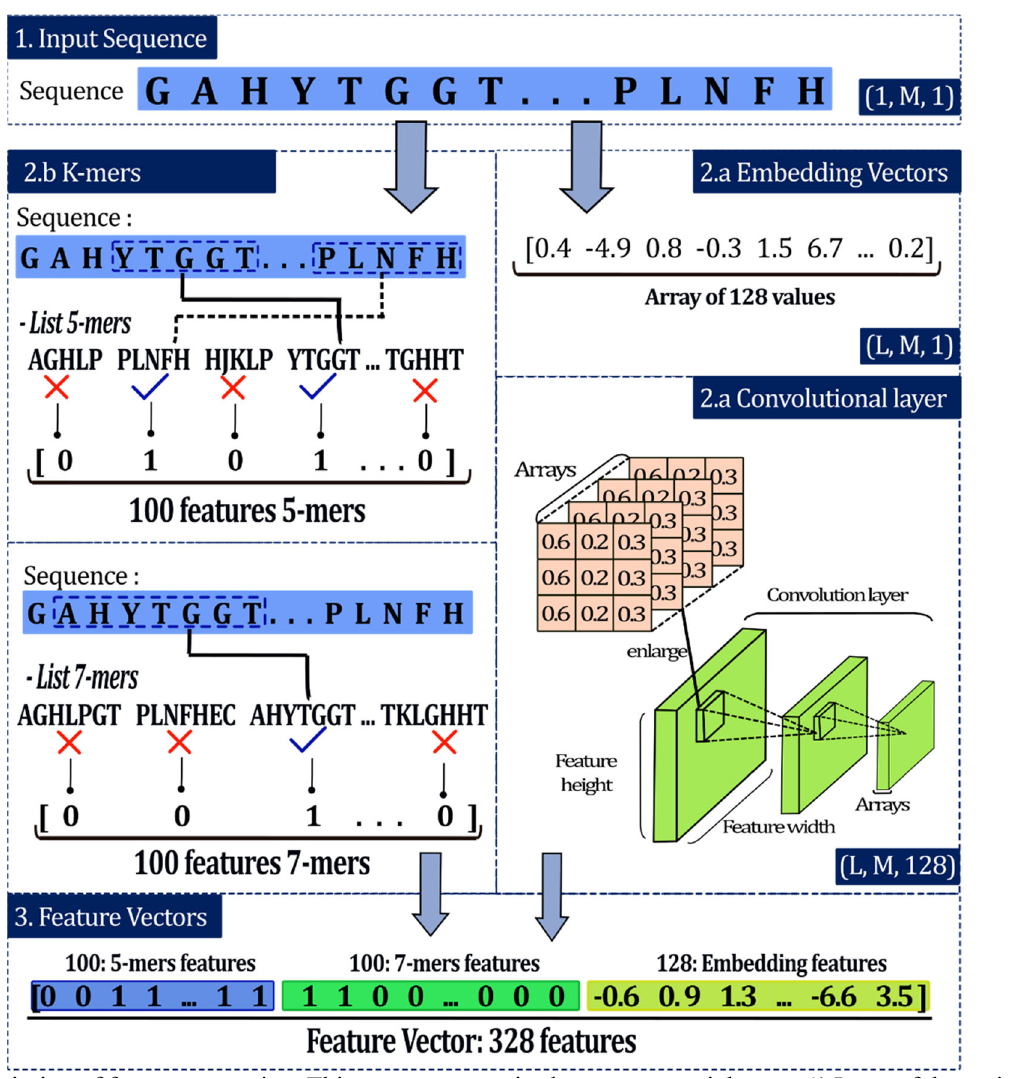
sequence and L is the length of the embedding